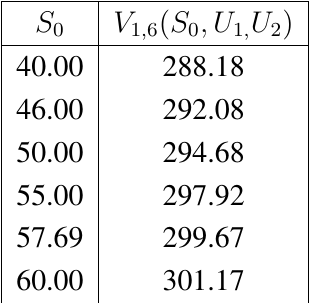
Table 4. Sensitivity